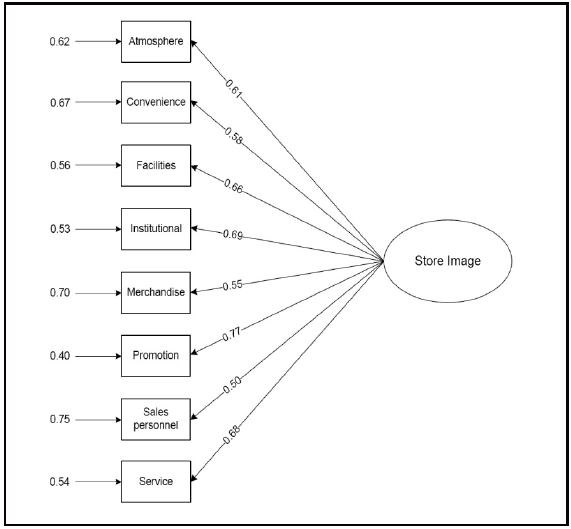
fIGuRE 1 Measurement model for the Simplified Model of Apparel Store Image – Mall intercept study